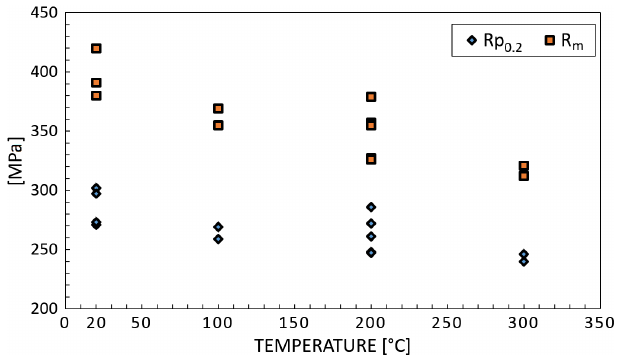
FIG. 15. Mechanical properties obtained from tensile tests on specimens that were extracted from notable position in a part that had the same dimension as the semifinished product from which the dump core blocks were machined.